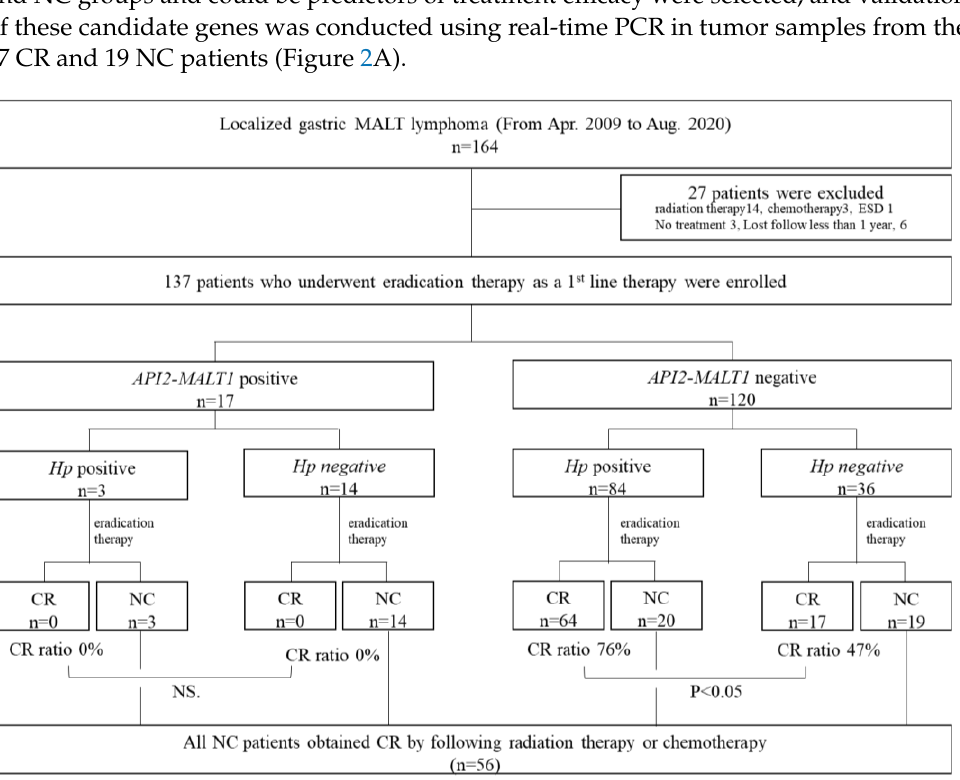
Figure 1. Inclusion and exclusion criteria and treatment outcomes. From 2009 to 2020, 164 patients were diagnosed with localized gastric MALT lymphoma in our hospital. Twenty-seven cases who underwent other treatments (radiation therapy, chemotherapy, ESD, and no treatment) as first-line therapy and who could not be followed up for more than 1 year were excluded from this study. Flowchart of treatment administered to patients classified by the API2-MALT1 chimeric transcript and Hp infection status. All patients underwent eradication therapy as first-line therapy. Non-responders to eradication therapy achieved a CR after RT. There were 17 API2-MALT1 (+) patients. None of these patients achieved CR after eradication therapy; however, all achieved CR after RT. Among the API2-MALT1 (−) cases, 76% of the Hp (+) cases and 47% of the Hp (−) cases achieved CR after eradication therapy.